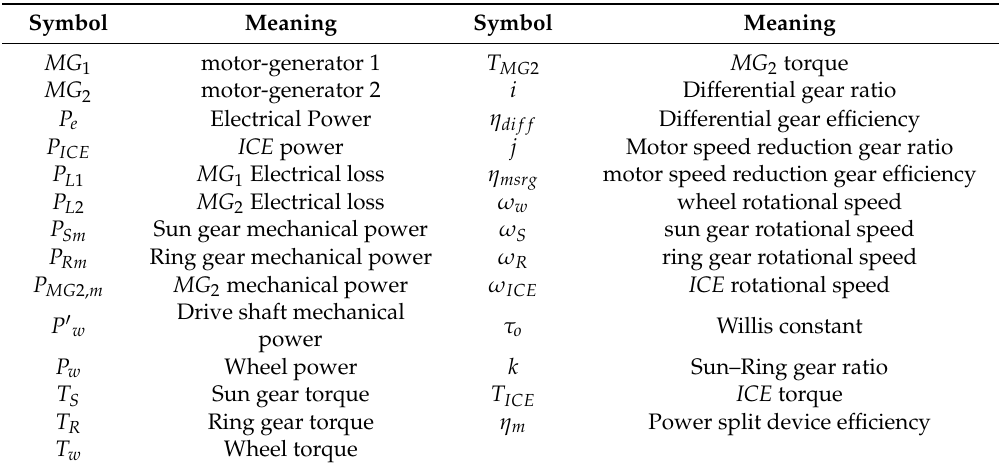
Table 1. Variable meanings.